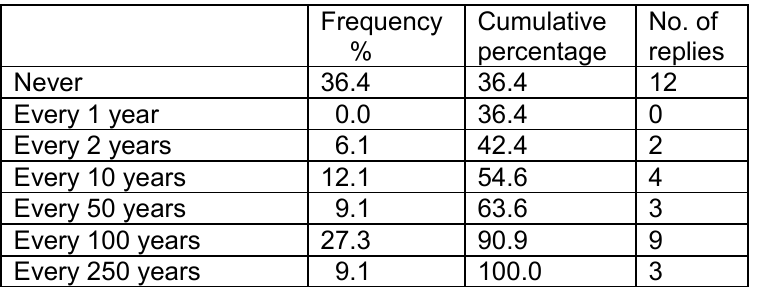
Table 3 Summary of responses about perceived flood risk